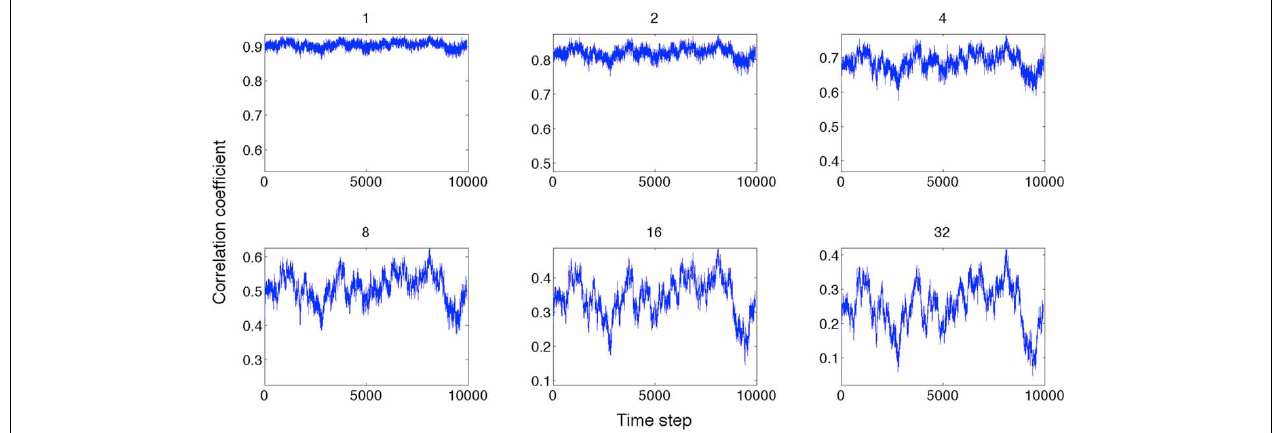
FIGURE 6 | Global state correlation as a function of time at various time lags (shown on top of each panel). Global state patterns become decorrelated at increasing time delays.